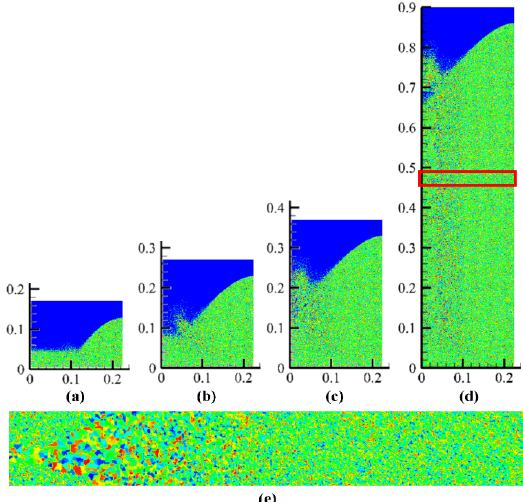
Figure 5. Evolution of the grain structure predicted in the grain-refined billet (case 1): ( a ) 100 s, ( b ) 200 s, ( c ) 300 s, ( d ) 830 s, with ( e ) the enlargement of grain structure confined by the red rectangle drawn in ( d ). Grains are distinguished by different colors.